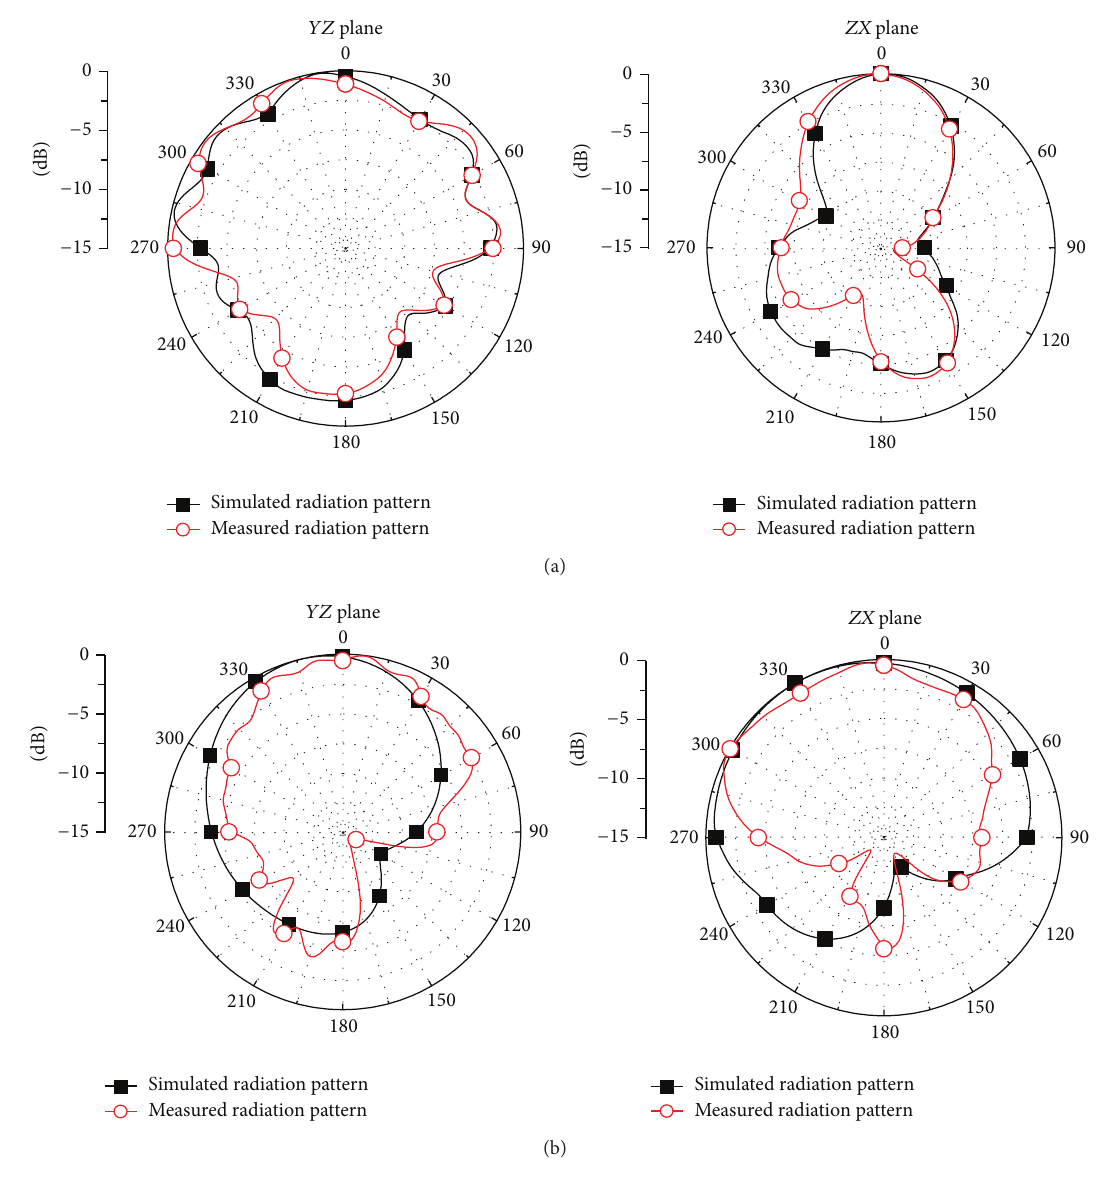
Figure 4: Radiation pattern of the proposed antenna without metallic object: (a) 920 MHz and (b) 2.425